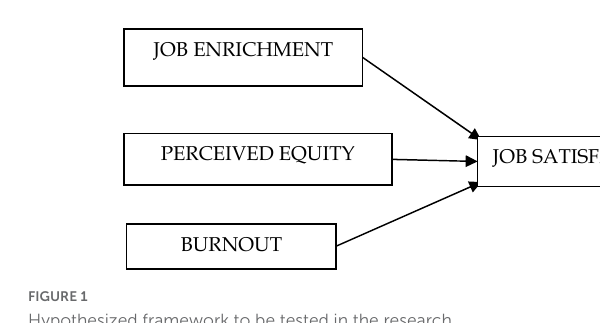
FIGURE1 Hypothesized framework to be tested in the